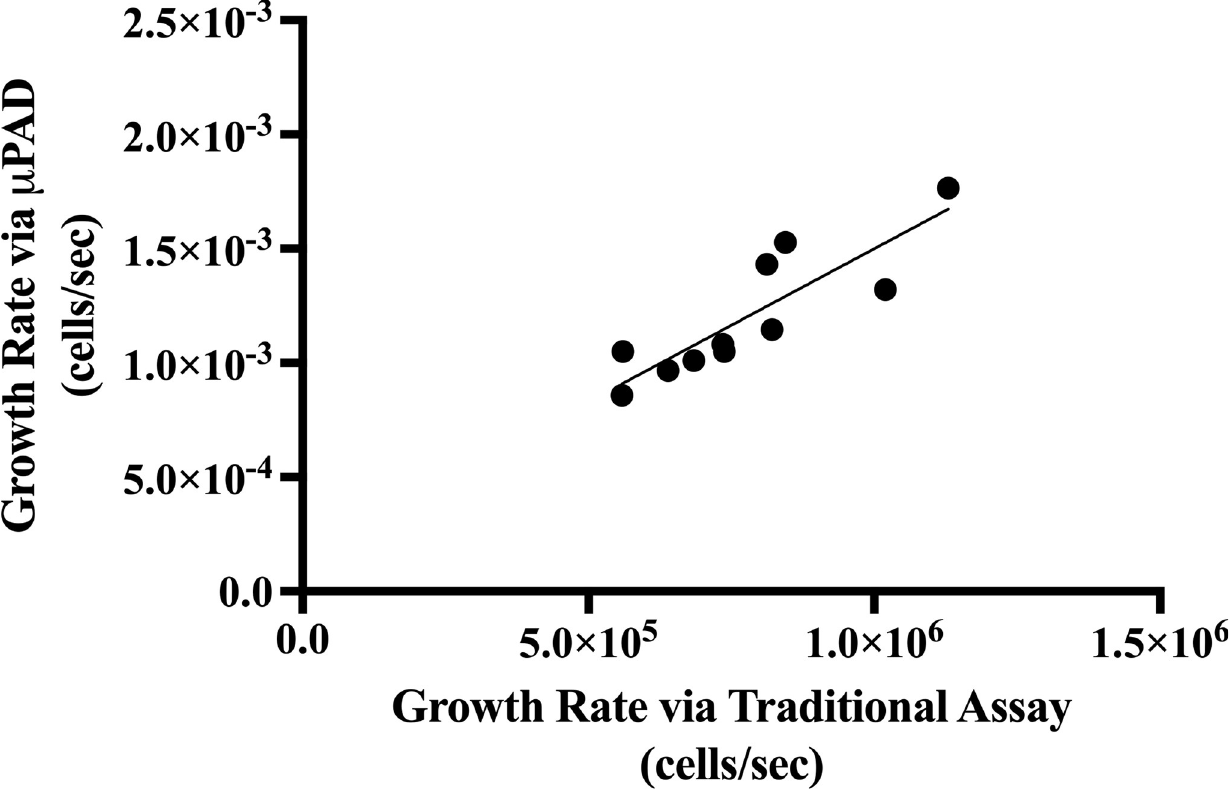
Fig 6. Comparison of growth rate measurements via traditional and μ PAD assays for S . cerevisiae cycloheximide gradient. The relationship between the S . cerevisiae growth rate (cells/sec) measured by the traditional spectrophotometric method (x-axis) and the proposed μ PAD method (y-axis) can be modelled by the equation, y = (1.34 × 10^(-9)) x + (1.59 × 10^(-4)). This model accounts for 74.35% of the variability in the data per R 2 interpretations.